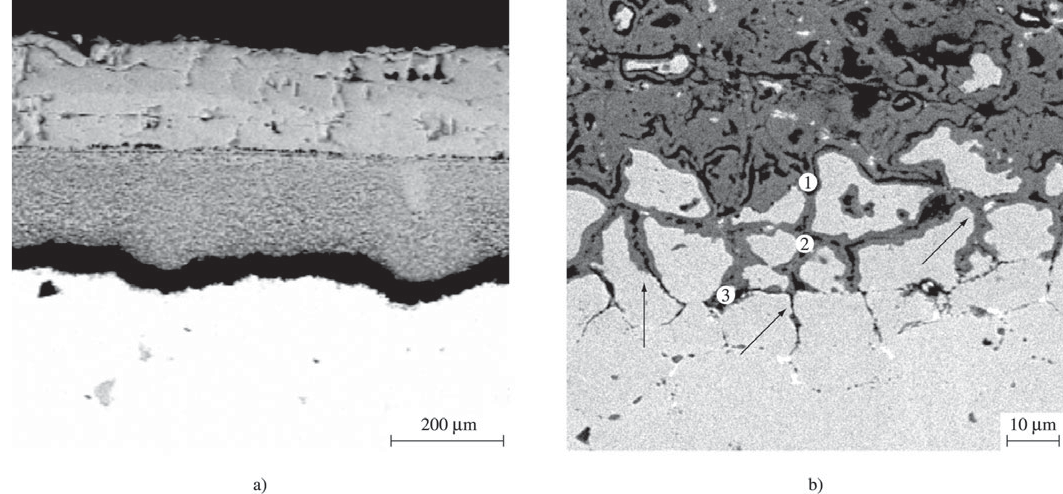
Figure 8. SEM cross-section of the G11 steel sample subjected to the simulated condition at 700 °C. a) General view of the corroded layer and substrate showing in detail the detachment of the layer from the substrate; b) Detail of the corroded layer/substrate interface, showing the internal oxidation and